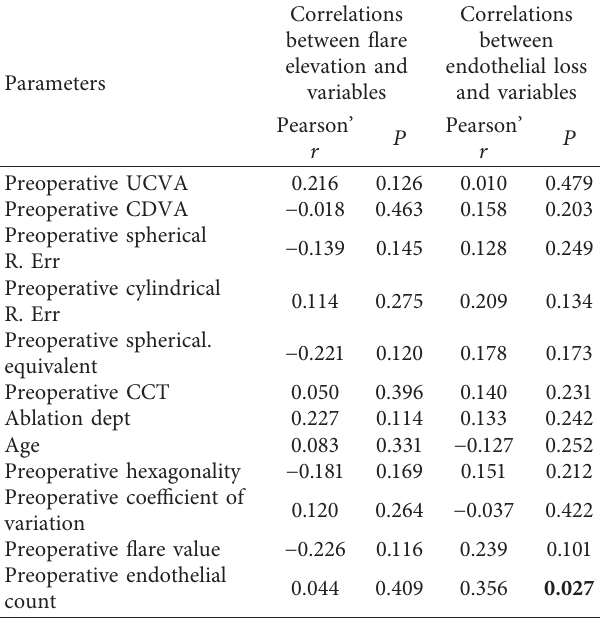
Table 4: Correlations for flare elevation on the postoperative 1 st day and endothelial cell loss (linear regression